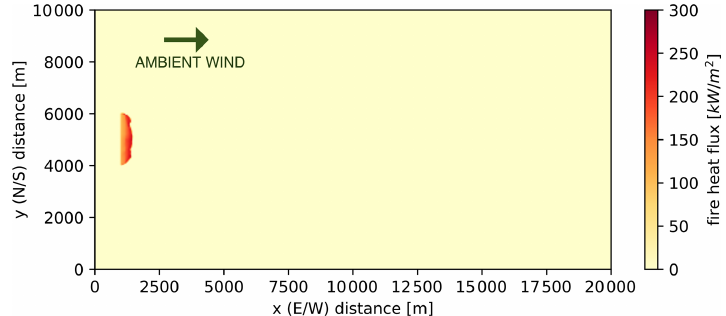
Figure A1. Numerical domain